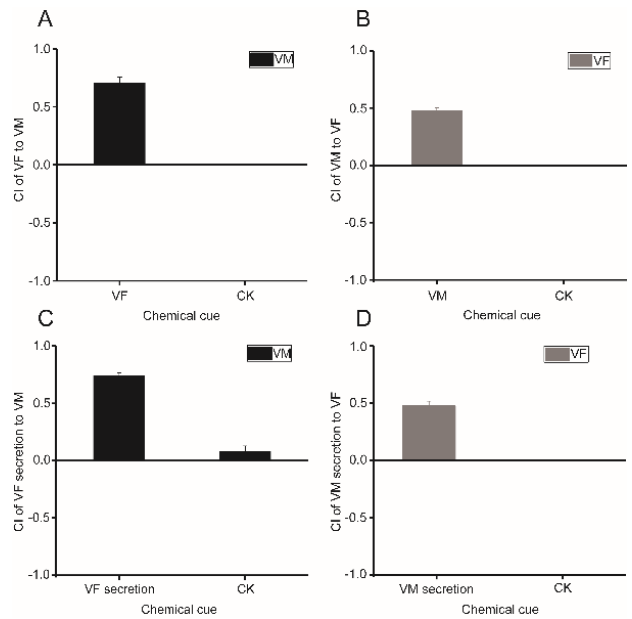
Figure 1. The attractiveness of VF, VM, and their secretions to the opposite sex. ( A , B ) The attractiveness of VF /VM to VM/VF. ( C , D ) The attractiveness of VF/VM secretion to VM/VF. CK: control of VF/VM: chemotaxis assay with M9 on the two spots. CK of VF/VM secretion: chemotaxis assay with ddH 2 O on the two spots. CI (chemotaxis index) = ((number of nematodes at the test zone) − (number of nematodes at the control zone))/total number of nematodes. VF: virgin female, VM: virgin male.